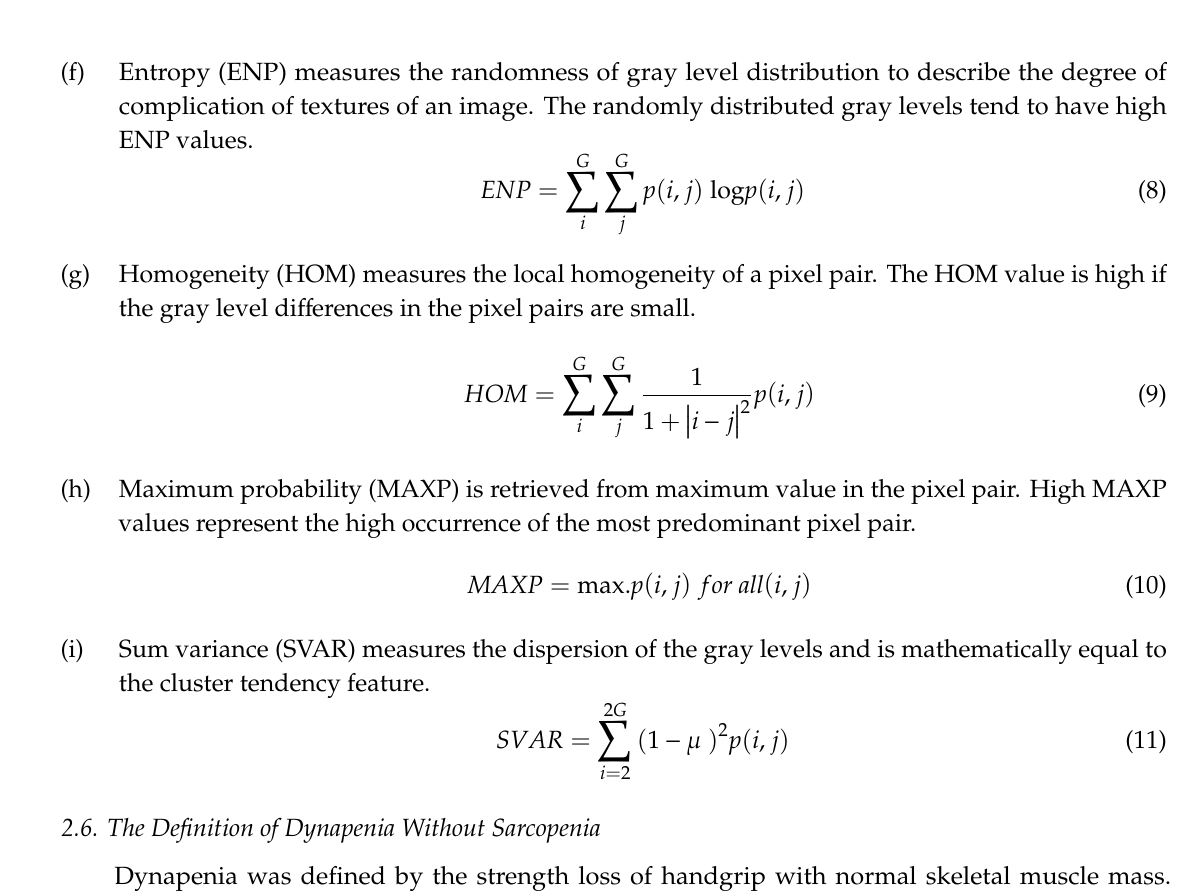
Sum variance (SVAR) measures the dispersion of the gray levels and is mathematically equal to the cluster tendency